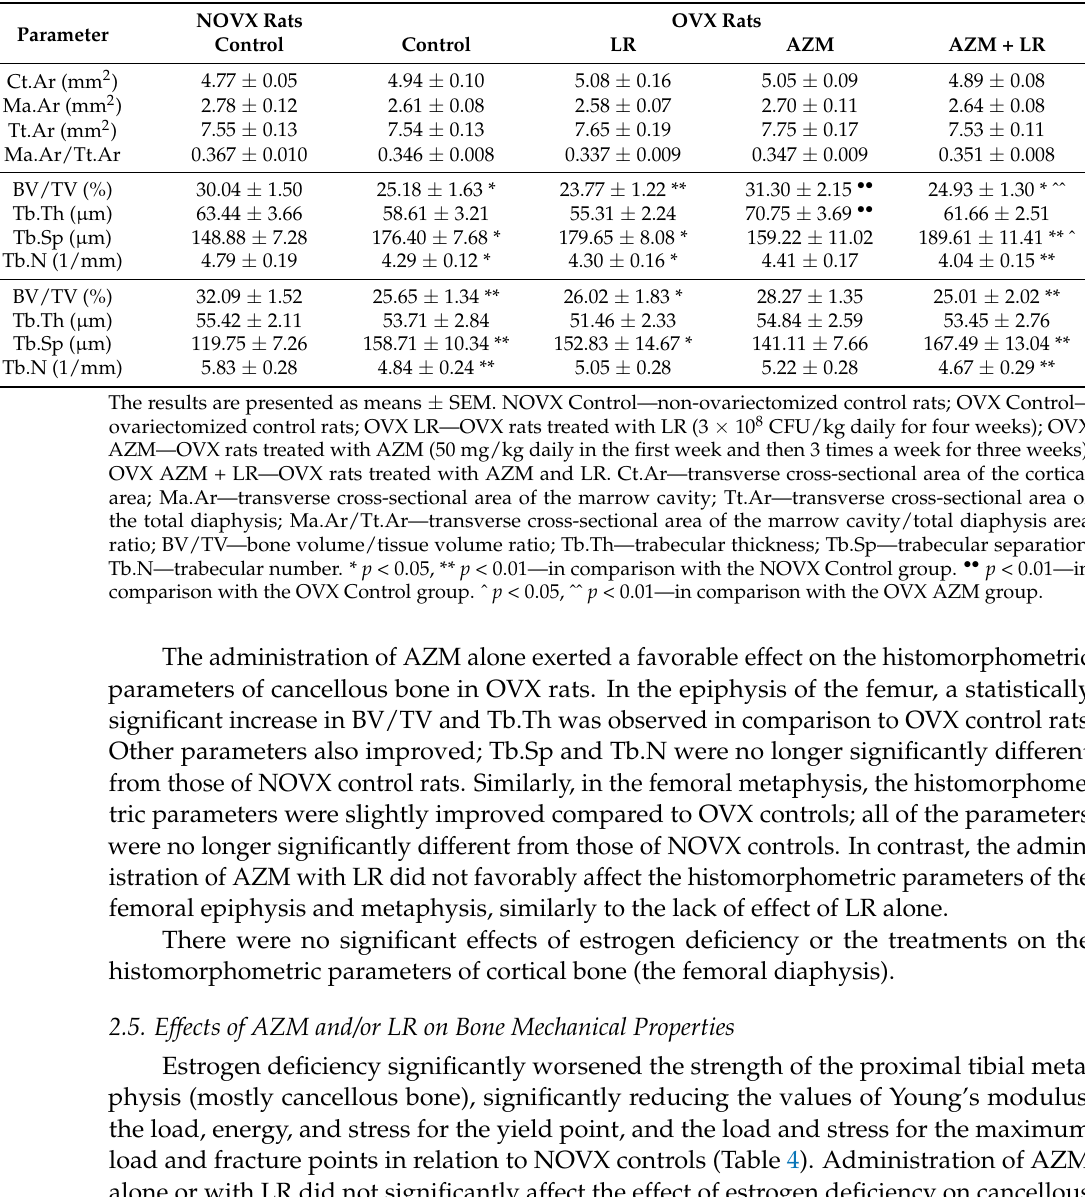
Table 3. Effect of azithromycin (AZM) and/or Lactobacillus rhamnosus (LR) on the histomorphometric parameters of the femur in ovariectomized